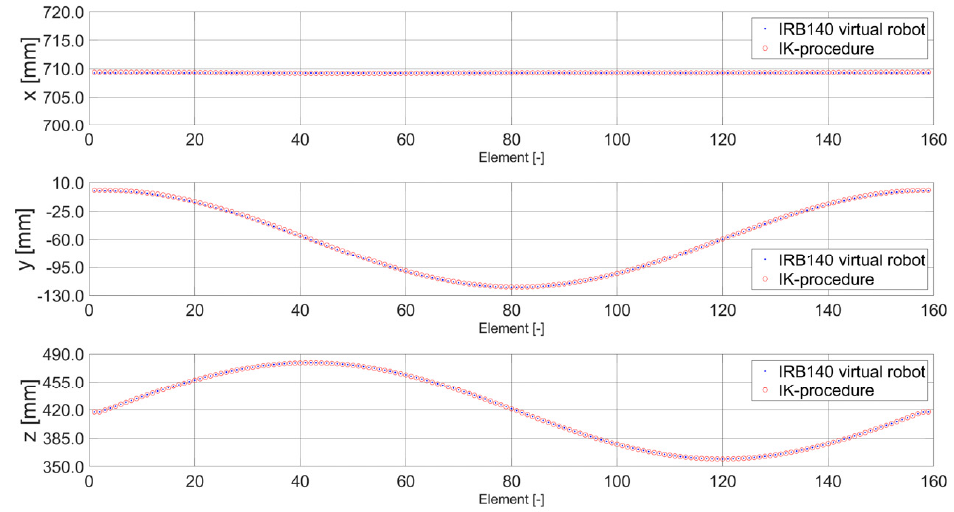
Figure 7. Circle in the Y-Z plane: X-, Y-, Z- axes Virtual IRB140 vs. IK procedure.